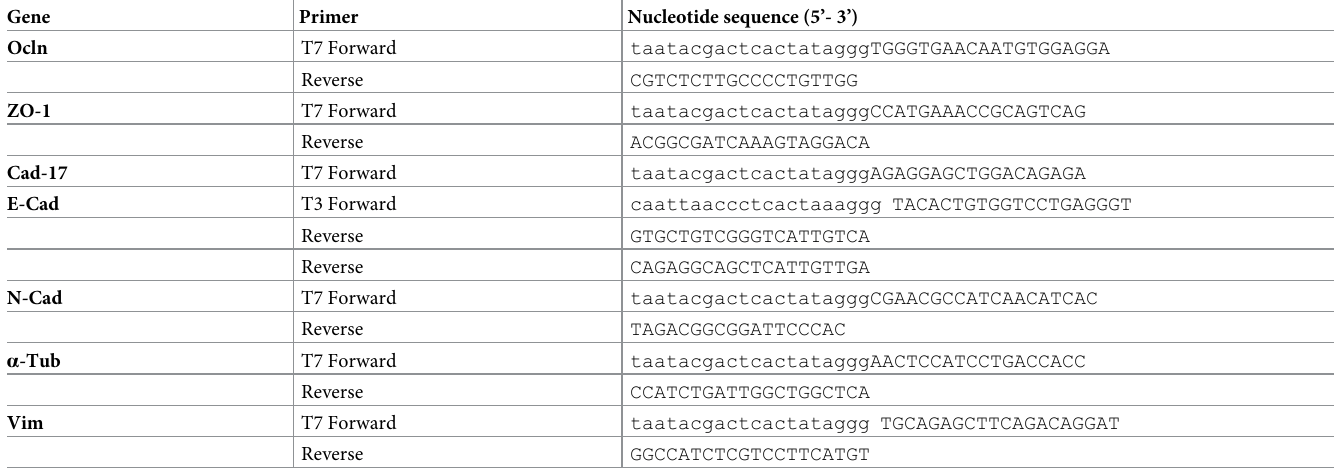
Table 4. Primers used for the synthesis of standard